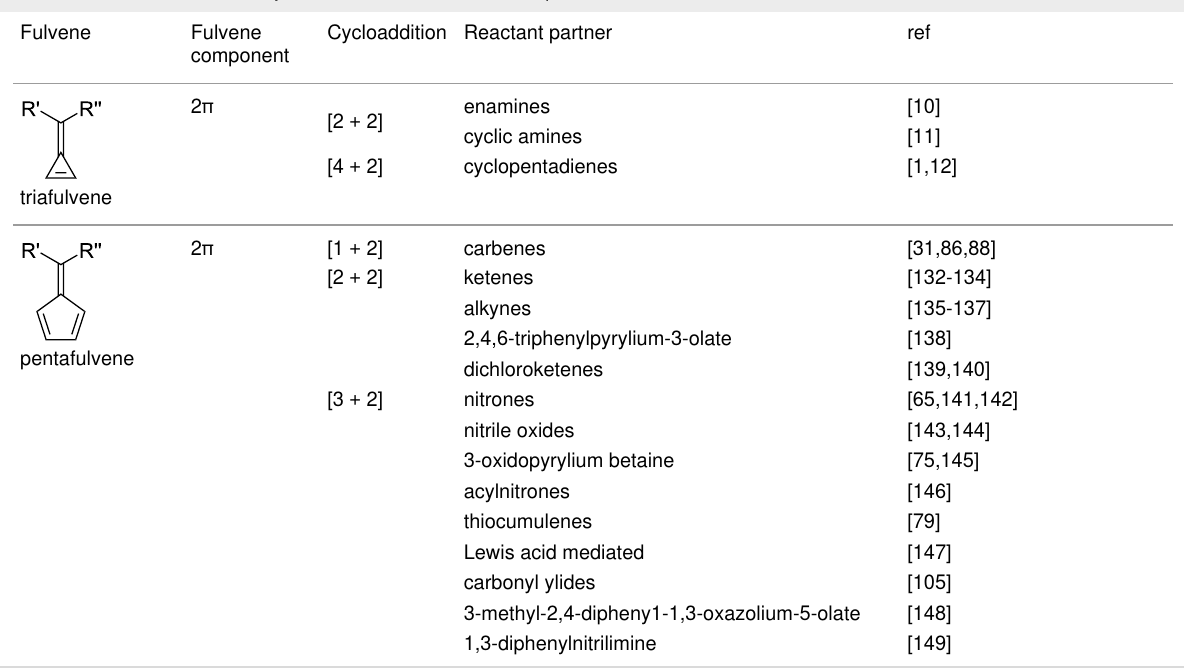
Table 2: Fulvene intermolecular cycloadditions with various reactant partners. Fulvene Fulvene component